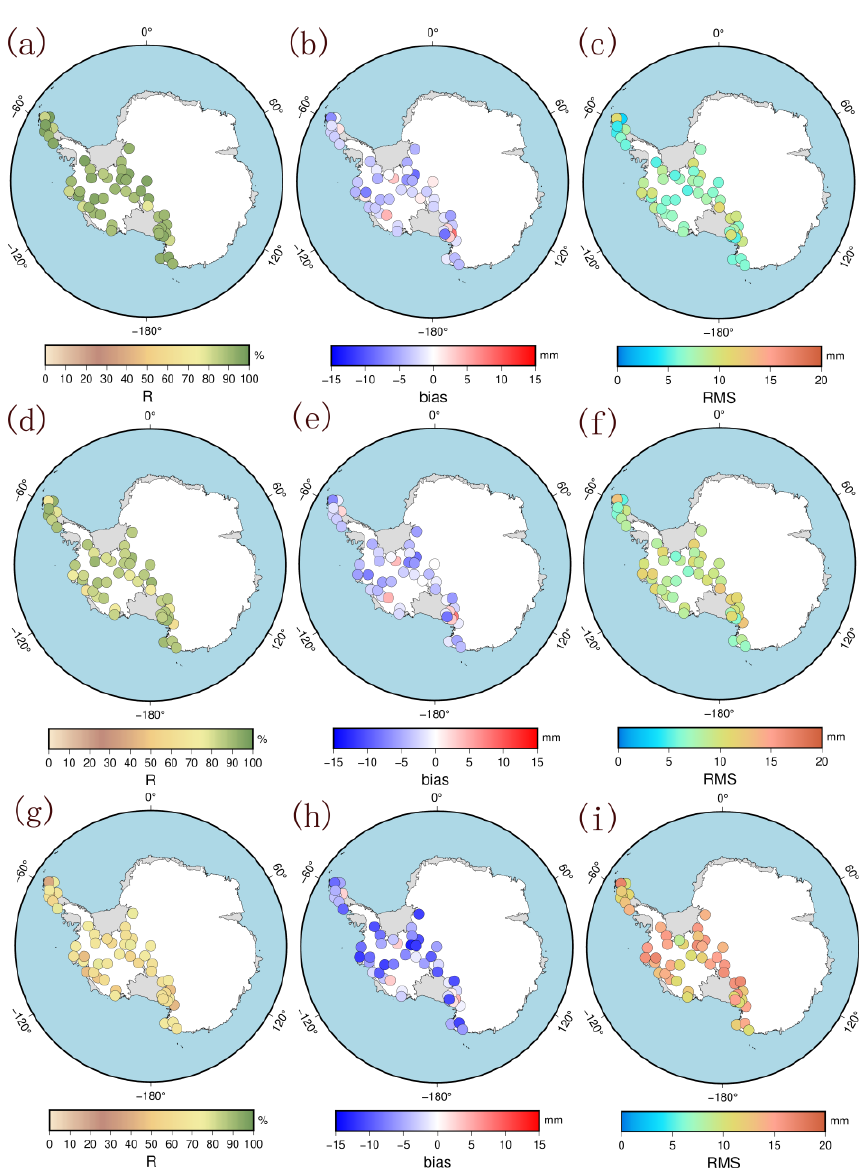
Figure 11. Distribution of correlation coe ffi cient R, bias, and RMS between the forecasting results and GPS-ZTD ( a , d , g ) are six-hour forecast results; ( b , e , h ) are 12 h forecast results; ( c , f , i ) are 24 h forecast